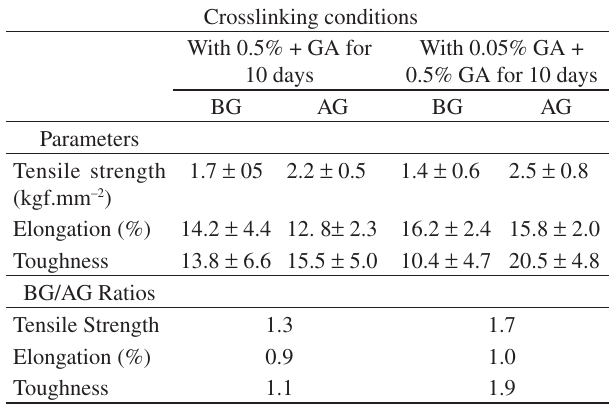
Table 1. Mechanical properties a of bovine pericardium crosslinked with glutaraldehyde under different conditions and with or without exposure to glutamic acid